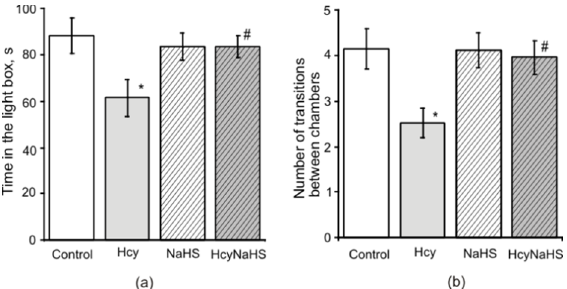
Figure 3. Effects of prenatal hHcy and NaHS treatment on anxiety measured in the light-dark box. The time spent in the light box ( a ) and numbers of transition between chambers ( b ) of rats compared to control (white columns), Hcy (grey columns), NaHS (dashed columns), HcyNaHS (grey dashed columns) groups. * p < 0.05 compared to the control group, # p < 0.05 compared to the Hcy group .